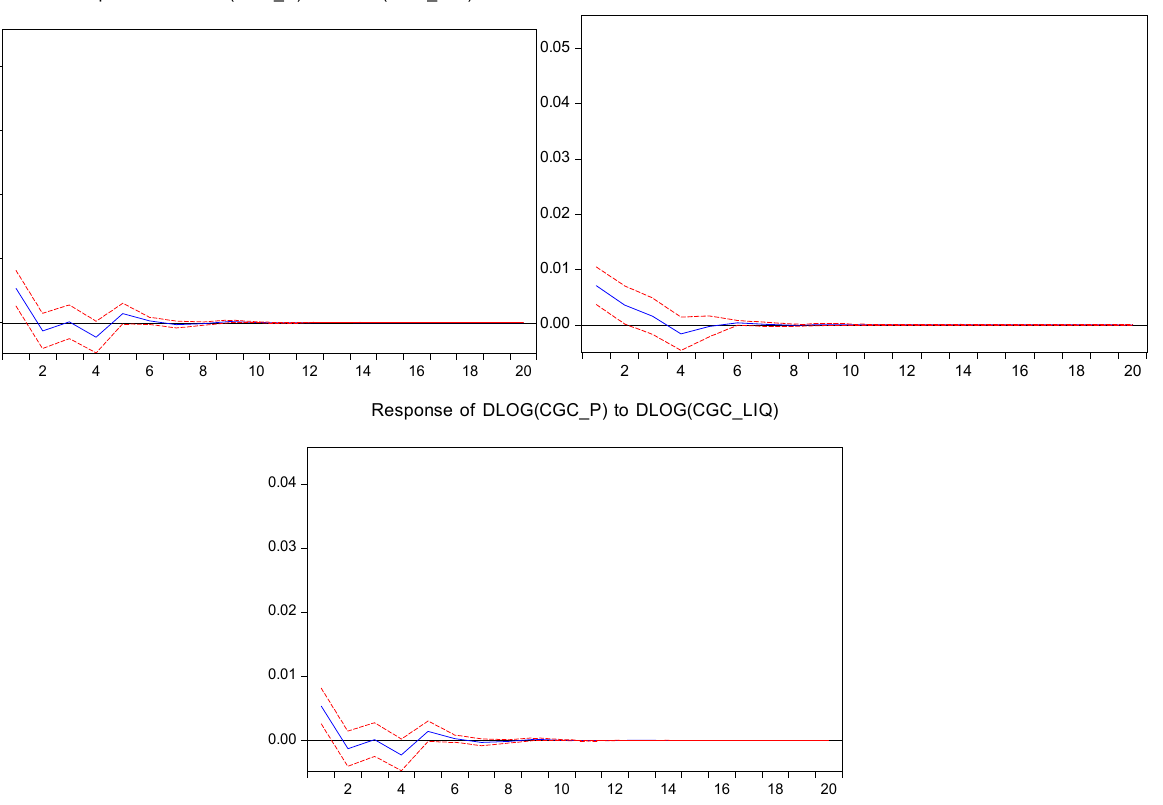
Figure 3. Impulse response function (liquidity → returns). This figure includes the generalized impulse response function in vector autoregressive (VAR) models studying the response of cannabis stock returns to shocks liquidity.